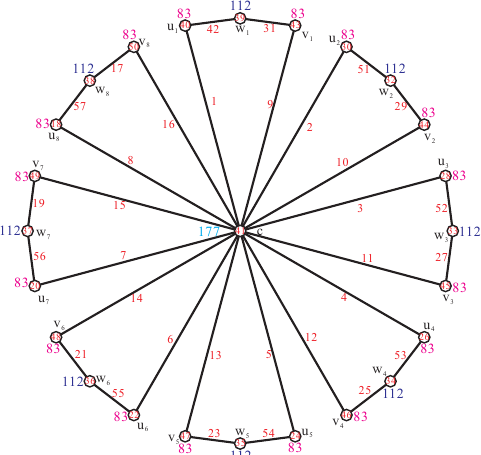
Figure 10. The local antimagic total labeling of D 8 . 4 The analogous Dutch windmill graph, denoted by AD n , is obtained from the Dutch 4 windmill graph D n by adding edges cw i for each i ∈ 1, 2, . . . , n . The graph AD n has 3 n + 1 4 4 vertices and 5 n edges. It can be seen that the analogous Dutch windmill graph AD n can be 4 viewed as from the wheel W 3 n by deleting one edge continuously every 2 edges on the rim of the wheel. The analogous Dutch windmill graph AD 4 is shown in Figure 11. 4